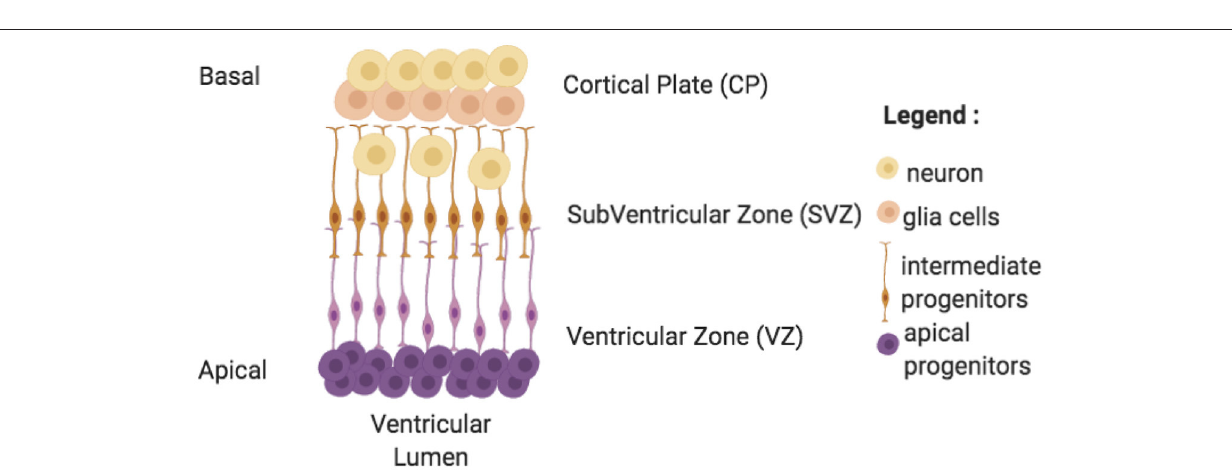
FIGURE 4 | Neuroepithelium formation inside cerebral organoids. This formation is present at discrete random locations around lumen ventricles in cerebral organoids. It grows from the apical perimeter thanks to progenitor cells to the basal zone. Cells migrate and differentiate along these axes. Cerebral organoids’ neuroepithelium are made of 3 zones: a ventricular zone (VZ), a subventricular zone (SVZ), and a cortical plate (CP) each composed of specific cell